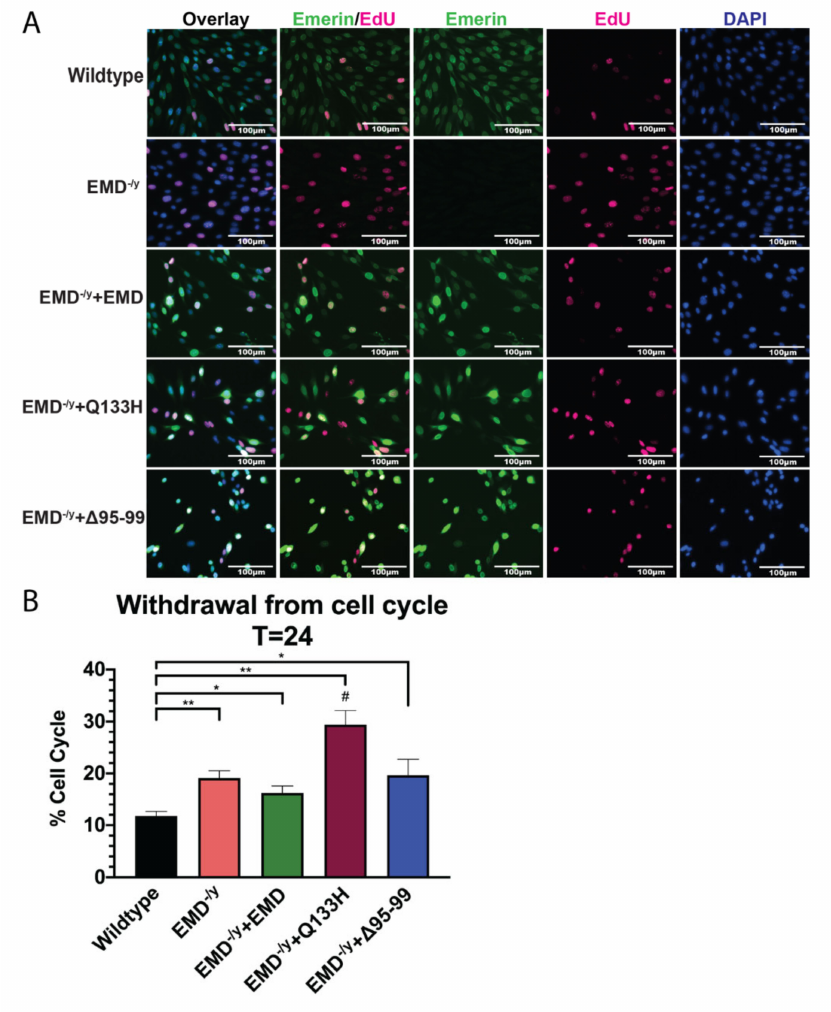
Figure 4. Cell cycle exit is impaired in EDMD-causing emerin mutant progenitors ∆ 95–99 and Q133H at 24 h post di ff erentiation induction. ( A ) Immunofluorescence images at 24 h post di ff erentiation induction. Scale bar: 100 µ m. ( B ) Cell cycle withdrawal at 24 h after di ff erentiation induction. Q133H and ∆ 95–99 emerin mutant myogenic progenitors fail to withdraw from the cell cycle. * p < 0.05, ** p < 0.02; # p < 0.05 compared to +